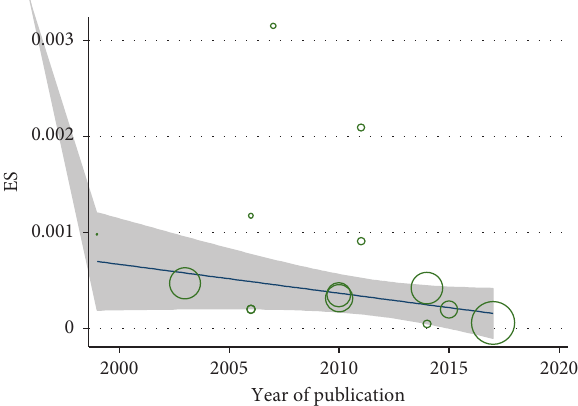
Figure 3: Relationship between the prevalence of infectious ker- atitis after performing the keratorefractive surgery with the year of publication of the article by using the meta-regression model.